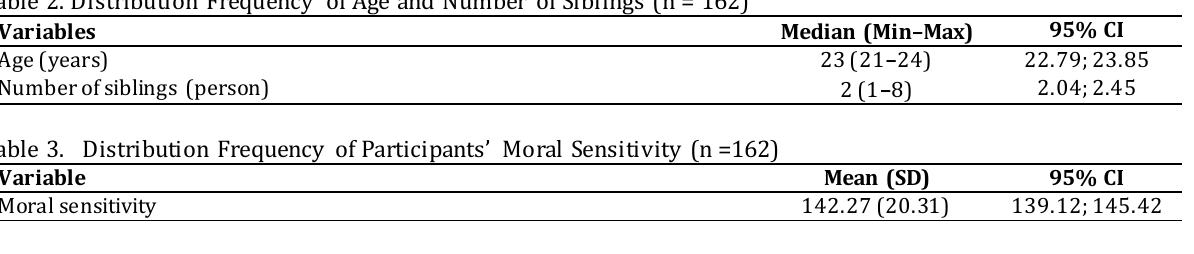
Table 4. Distribution Frequency o f Participants’ Moral Sensitivity Category (n =162) Variable